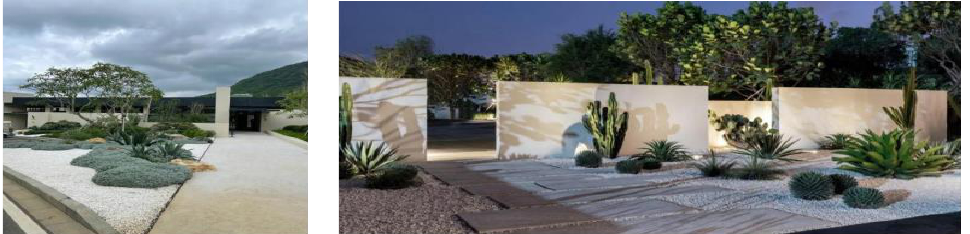
Figure 6. Anaya Scenic Area .